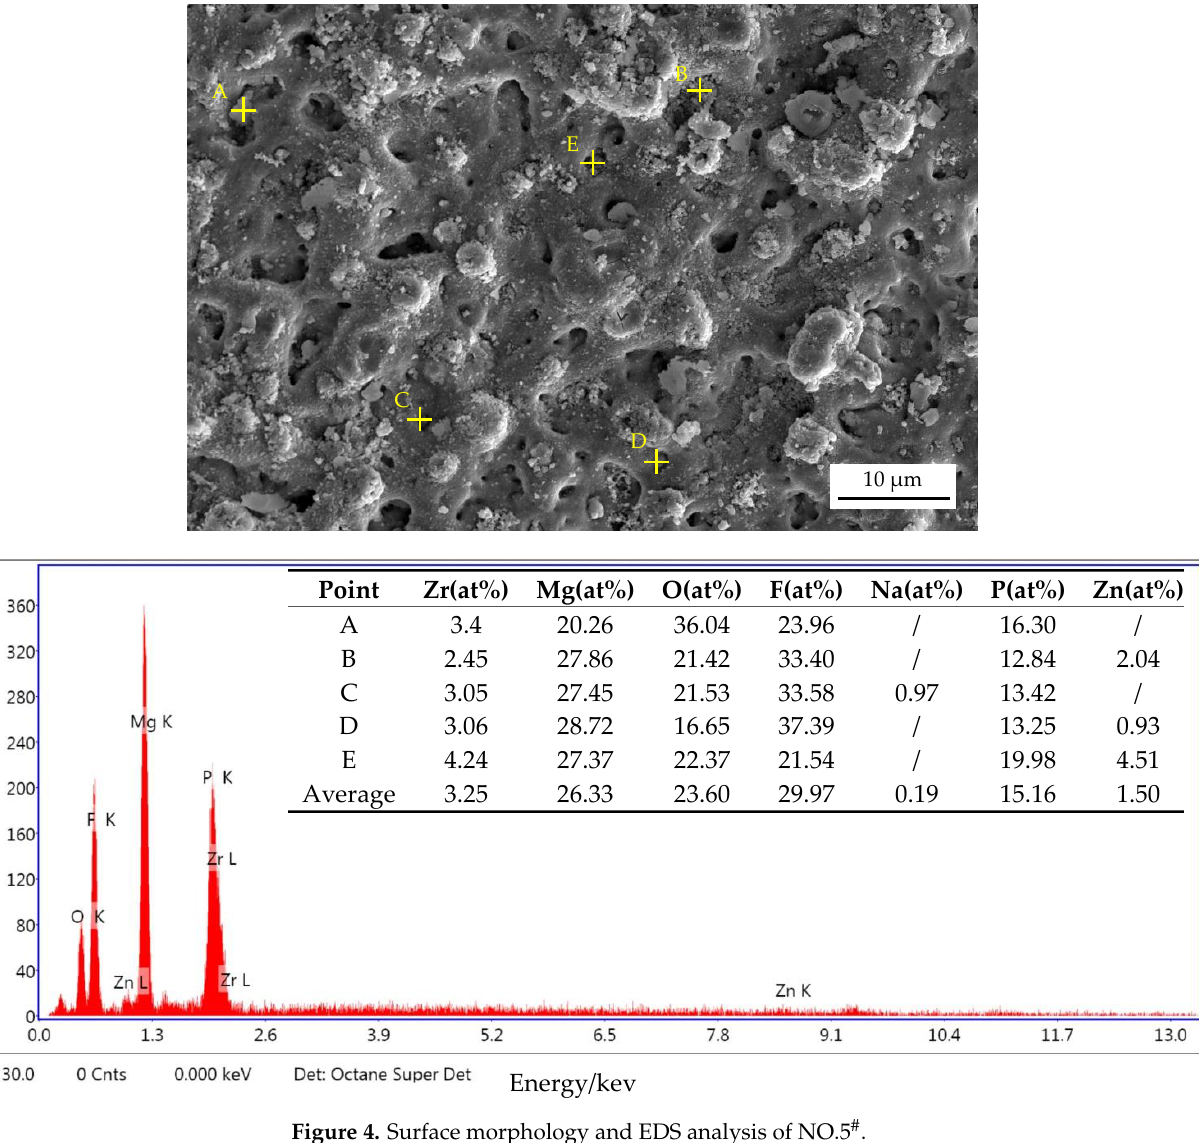
Figure 4. Surface morphology and EDS analysis of NO.5 # . Table 3. EDS analysis of the coating surface (1 # –9 # ) prepared in different parameters.